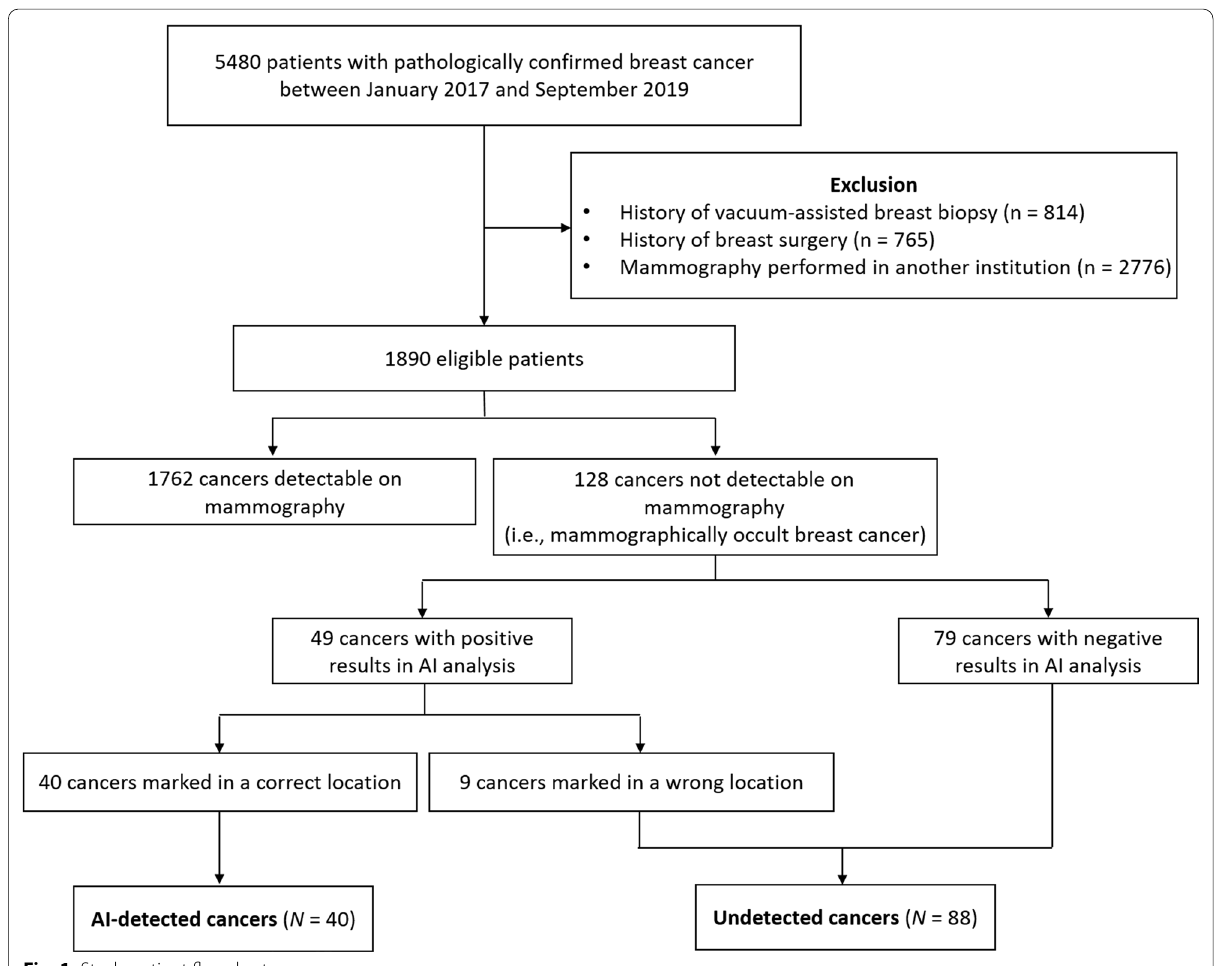
Table 1 AI analysis results of 128 mammographically occult breast cancers